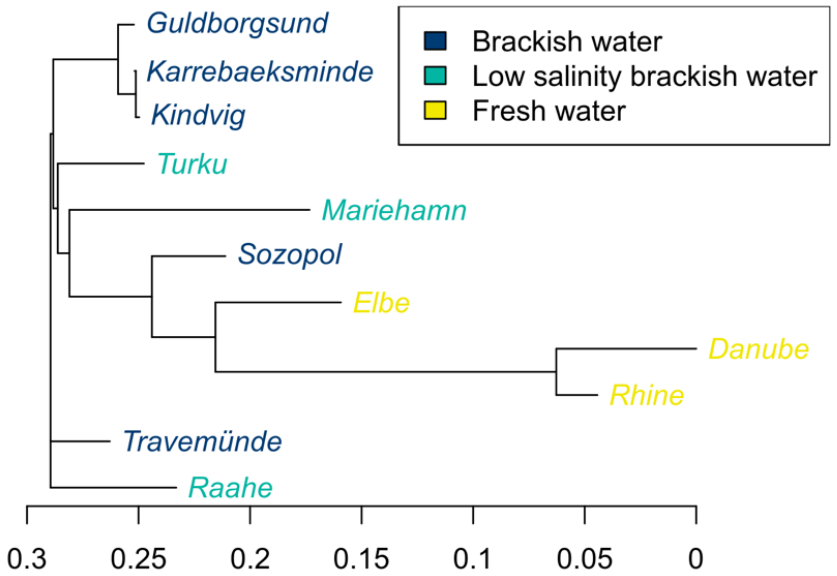
Figure 4. Neighbor-joining tree based on pairwise F ST calculated using 13,847 SNPs showing the phylogenetic relationships between round gobies ( Neogobius melanostomus ) collected from 11 sites. Colour represents environmental condition of population samples.